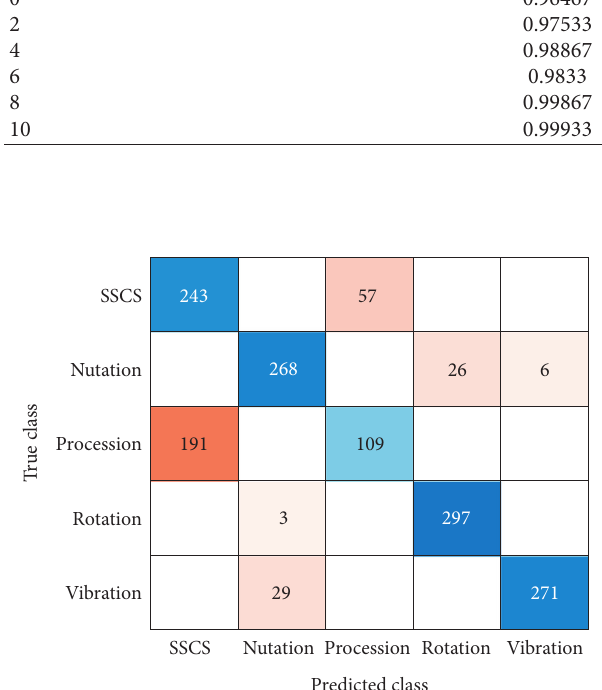
Figure 7: The confusion matrix of the network under − 10dB.